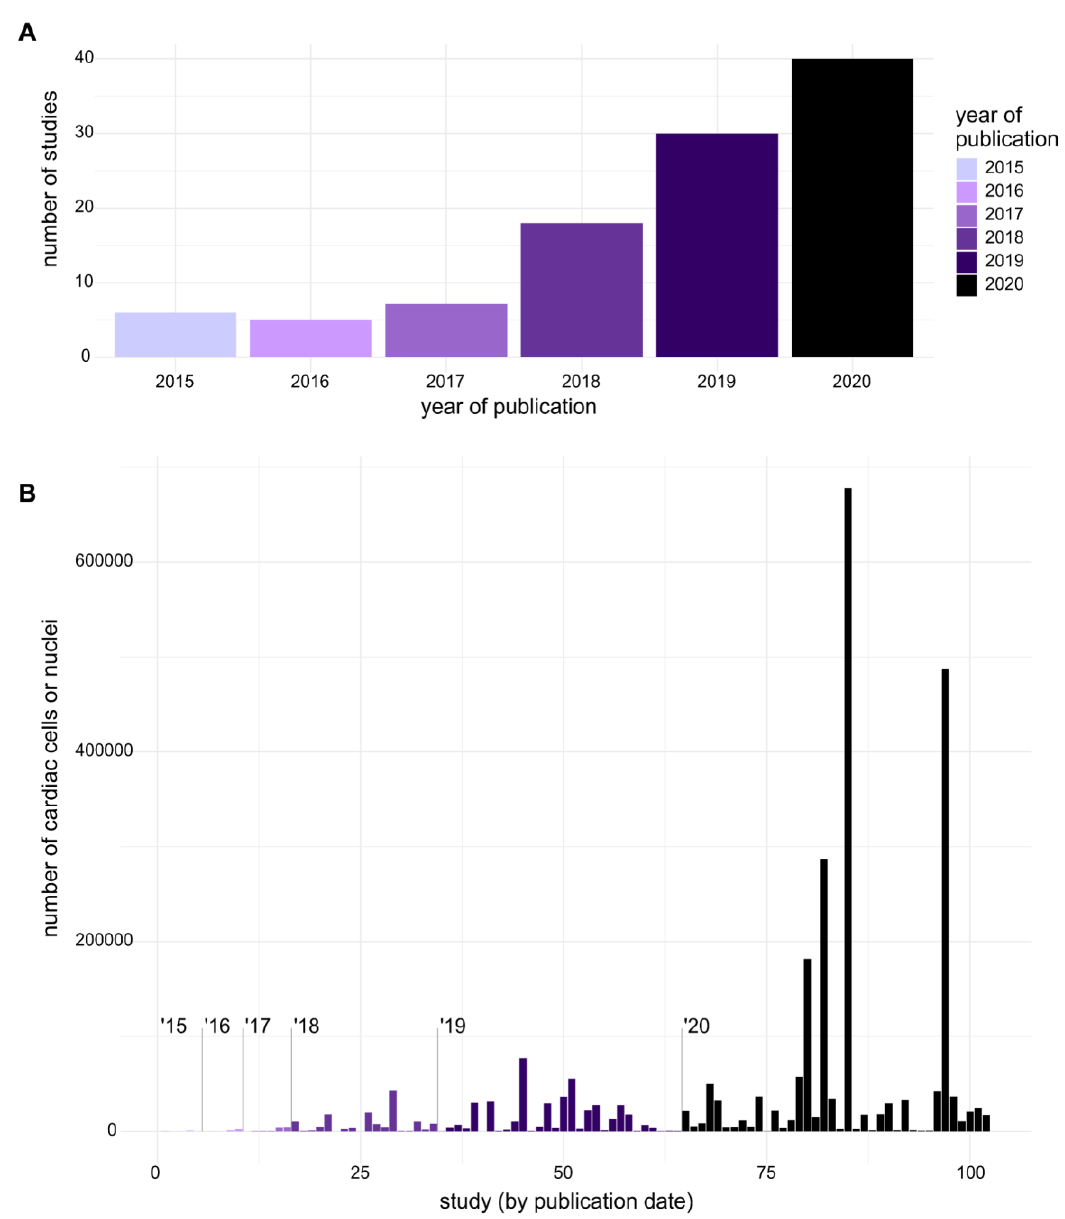
Figure 1. Overview of the exponential growth in single-cell transcriptomic studies from 2015 to 2020. ( A ) The number of published cardiovascular studies using single-cell transcriptomics per year. ( B ) The number of cells sequenced in each study. Studies in which the number of sampled cells could not be determined were omitted.